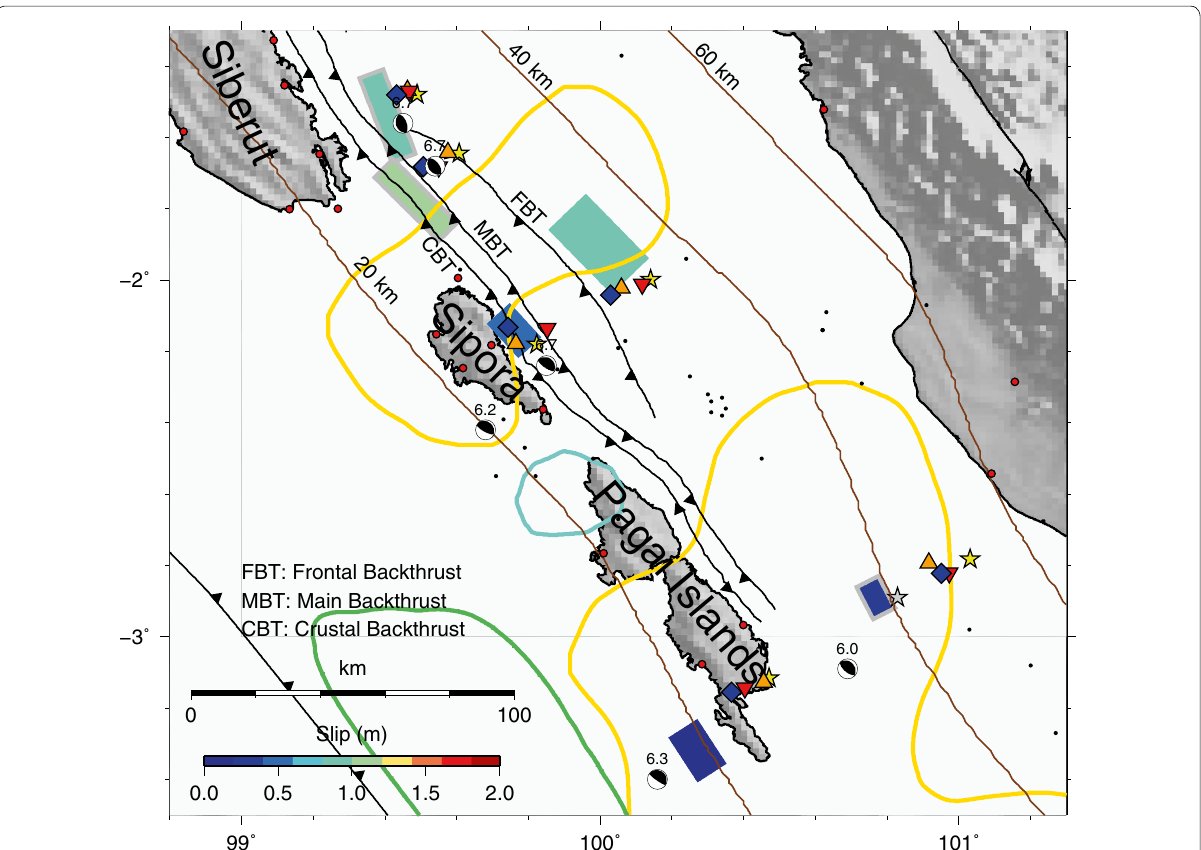
Fig. 8 Map of six modeled earthquakes in the Mentawai section. Black dots indicate seismicity between December 2007 and October 2008 located by Collings et al. (2012). Gray star indicates the epicenter of the 4 January 2008 event from Collings et al. (2012). Backthrust fault traces are taken from (Singh et al. 2010). See the captions of Figs. 1 and 6 for description of other